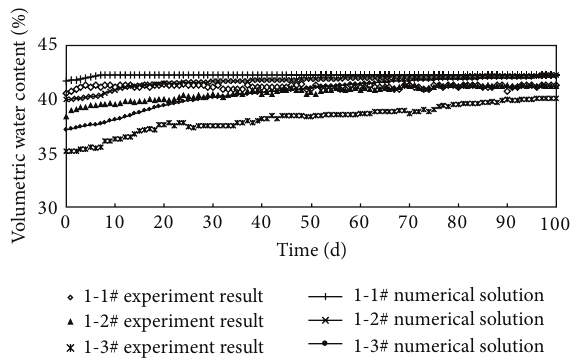
Figure 13: Comparison of calculated subgrade moisture with experimental results in Stage 2.